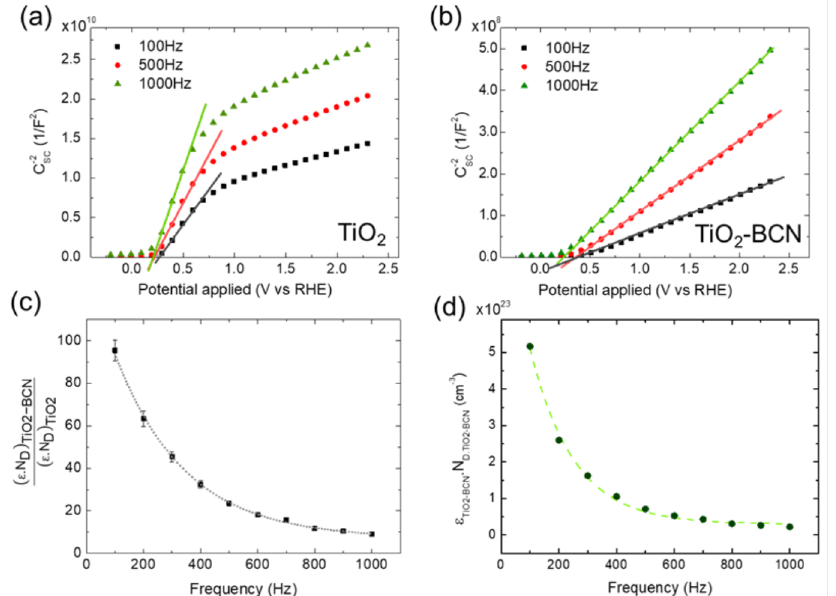
Figure 7. Mott–Schottky plot at three different frequencies for ( a ) sample TiO 2 and ( b ) sample TiO 2 -BCN. ( c ) Relationship between the dielectric constant and the density of donors ( ε · N D factor) of the sample TiO 2 -BCN over that of the bare TiO 2 , as a function of the frequency. ( d ) ε · N D factor for TiO 2 -BCN sample vs. the frequency. Fitting parameters of the exponential decay fittings represented by a grey dotted line in ( c ) and green dashed line in ( d ) are shown in Table